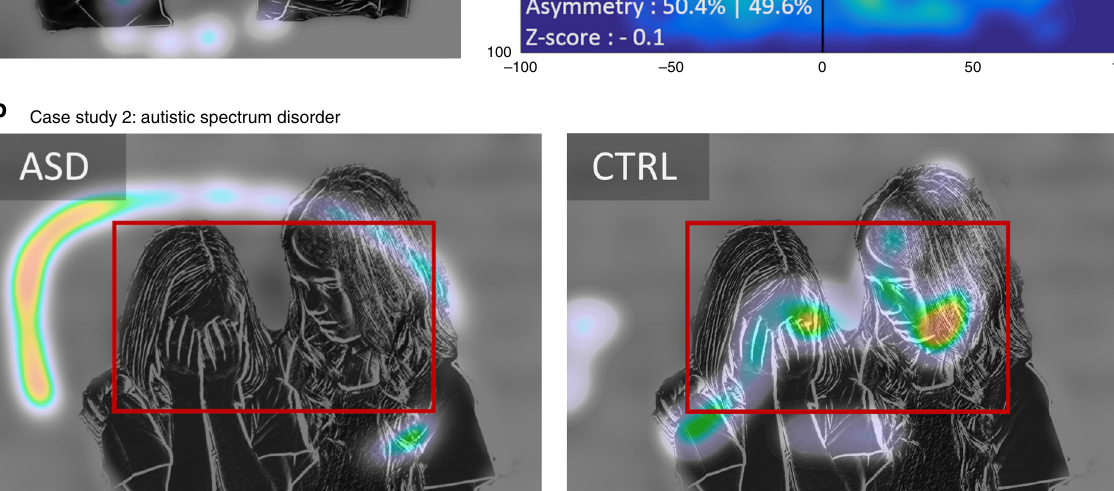
Then, we calculated the Receiver Operating Curves (ROC) derived from the estimated distributions to fi nally obtain evaluations of the classi fi cation performances using the AUC (Area Under the Curve). AUCs were estimated at 86.2 and 90.8% with Eye-tracker and with Digit-tracking, respectively (Fig. 5c). These high performances indicate that even a simple score derived from non-optimized blurred images explored with a fi nger on a tablet